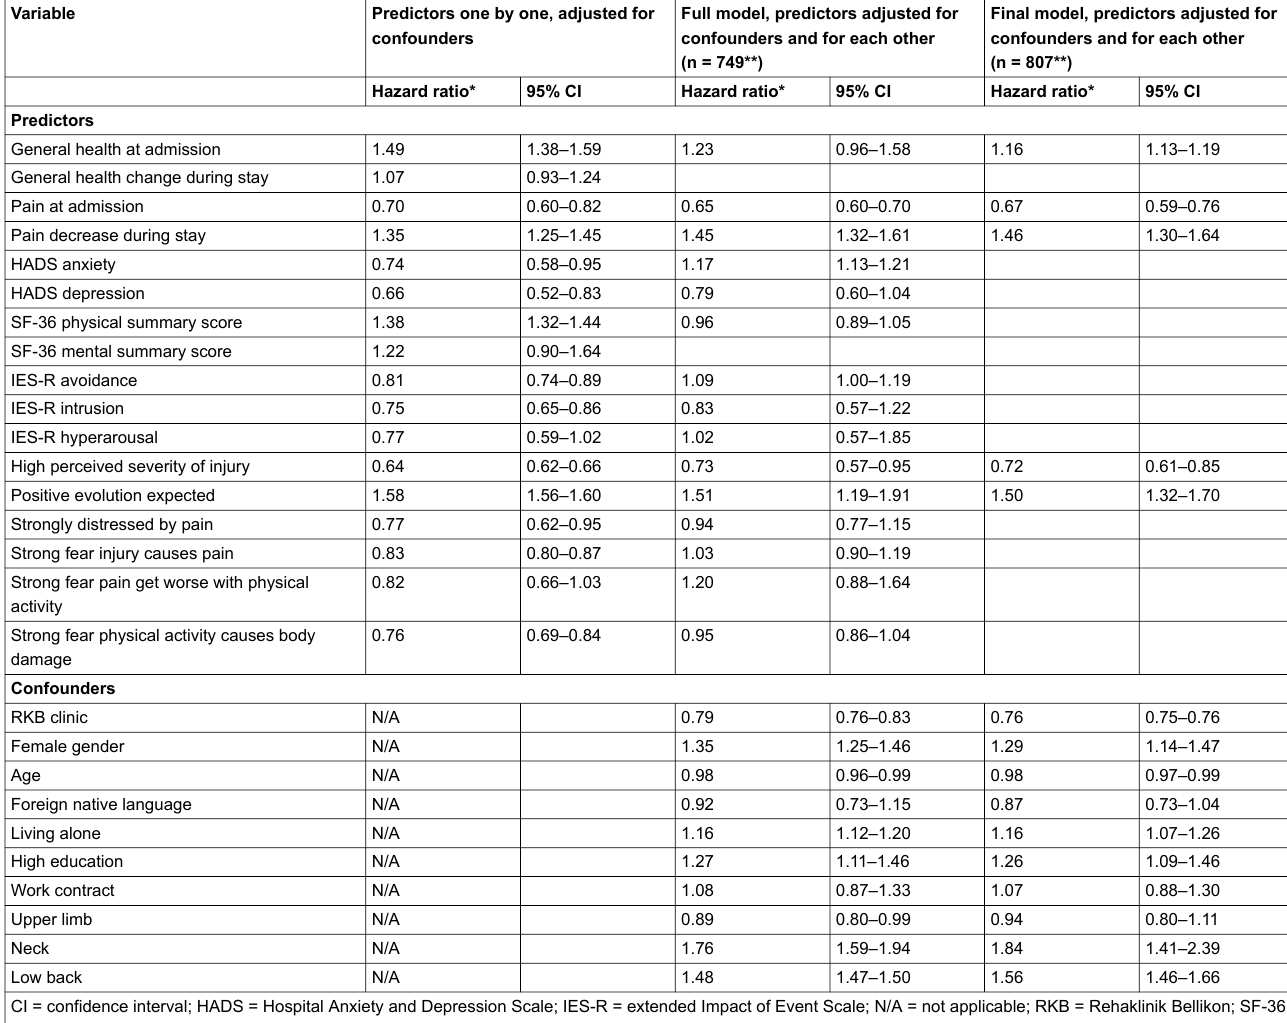
Table 3 : Cox models for time to fitness for work. A backward selection procedure was followed to end up with the final model. Variable Predictors one by one, adjusted for Full model, predictors adjusted for confounders confounders and for each